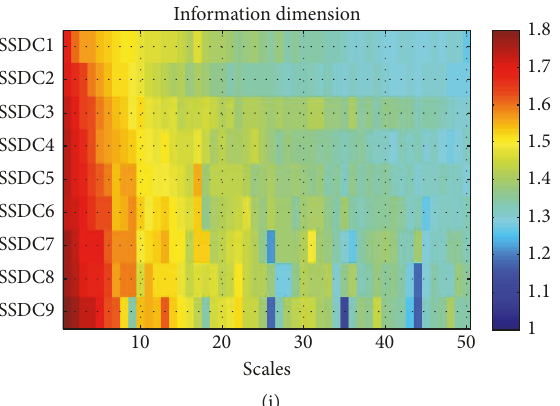
Figure 7: The multiscale information dimension of normal planetary gear and different degradation states. (a) Normal planetary gear, (b) breakage level 1, (c) breakage level 2, (d) breakage level 3, (e) breakage level 4, (f) pitting level 1, (g) pitting level 2, (h) pitting level 3, and (i) pitting level 4.